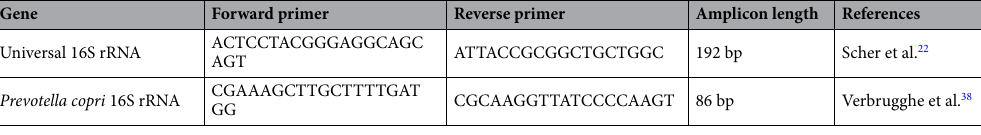
Table 4. Primers used in the qPCR